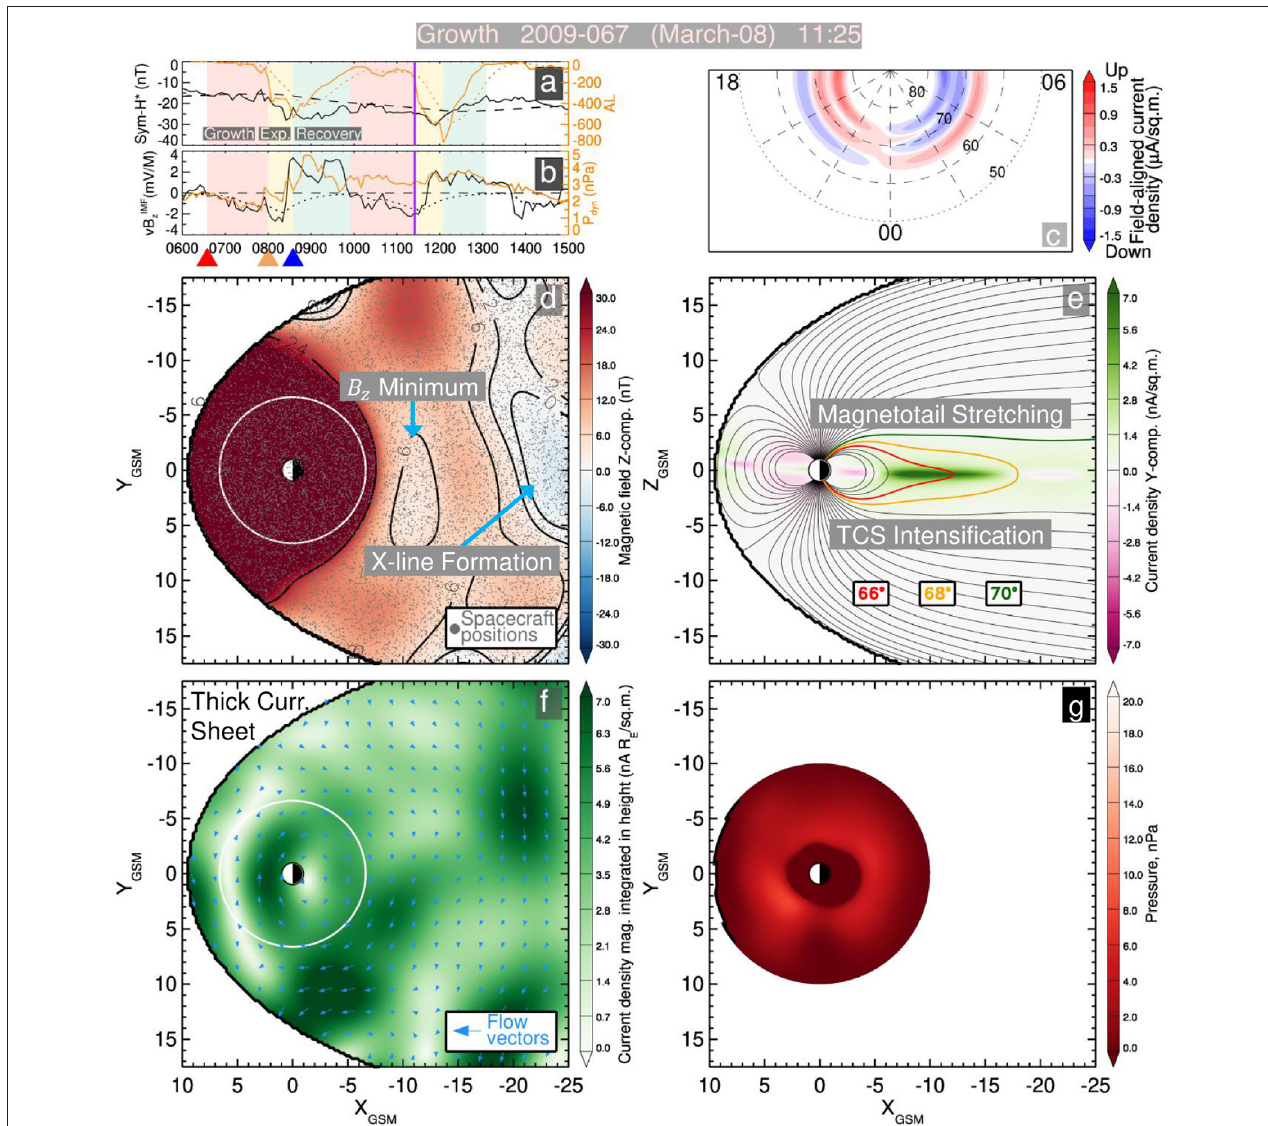
FIGURE 6 | The merged resolution model’s reconstruction of the late growth phase of the 8 March 2009 substorm. (a) Geomagnetic indices: the pressure-corrected storm index Sym-H ∗ and substorm index AL in solid black and orange lines, respectively. Their smoothed values G ( sst ) 1 ( t ) dashed black and dotted orange lines, respectively. (b) Solar wind parameters: the electric field vB IMF z and dynamic pressure P dyn in solid black and orange lines, vB IMF s shown as the dotted black line. The vertical purple lines in (a,b) represent the moment in time. (c) The pattern of FACs flowing into respectively, with G ( sst ) 5 ( t ) = h | (blue) and out of (red) the ionosphere. (d) The equatorial distribution of the total modeled magnetic field. The simulated magnetic field observations used to fit the model are overplotted with gray dots. (e) The meridional distribution of the Y component of the current density showing current flowing out of the page (green) and into the page (purple). Magnetic field lines originating from the ionosphere (ranging from 60 to 90 ◦ magnetic latitude with 2 ◦ steps), three of which are highlighted: 66 ◦ (red), 68 ◦ (yellow), and 70 ◦ (green). (f) The height integrated equatorial distribution of the thick current sheet’s current density integrated from 0 overplotted arrows show the direction and magnitude of the current density vectors. (g) The equatorial distribution of the pressure computed by integrating j according to Equation